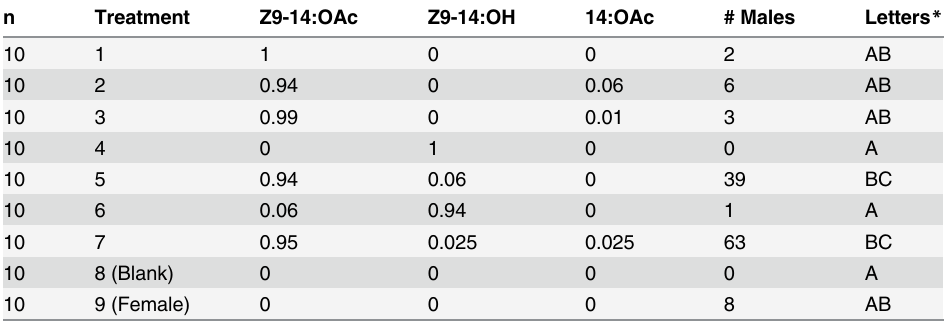
Table 5. Field trial treatment ratios, by volume, and number of males caught per treatment. n